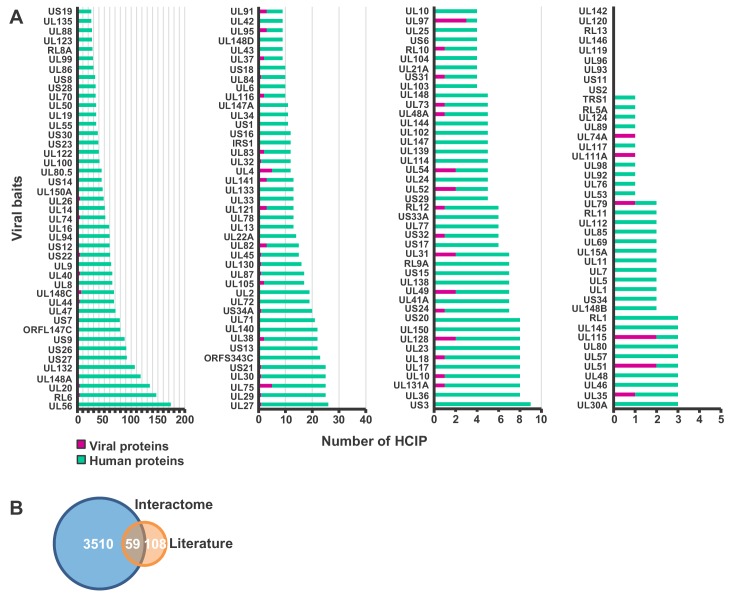
Further details of interactions.(A) Number of HCIPs per bait excluding bait-bait interactions. Four graphs with different x-axis scales illustrate the range of interacting viral or cellular proteins per bait. Gridlines are displayed at each log interval. Full data is shown in Supplementary file 2A. (B) Validation of the interactome data from BioGRID, IntAct, Uniprot, MINT, and Virus Mentha (Calderone et al., 2015; Chatr-Aryamontri et al., 2013; Licata et al., 2012; Orchard et al., 2014). 167 virus-virus and virus-host interactions were identified from these databases. Of these, 127 were identified in unfiltered data from the HCMV interactome, and 59 passed the stringent scoring thresholds employed (see also Supplementary file 3). Full details of all HCIPs are given in Supplementary file 2.